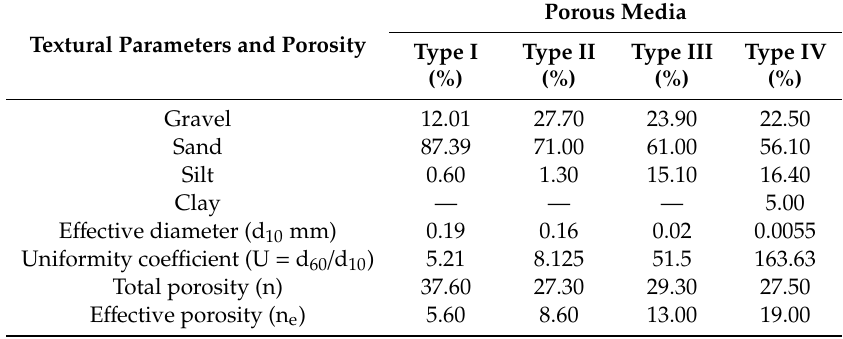
Table 2. Contents in percent of gravel, sand, silt and clay and values of effective diameter, uniformity coefficient,